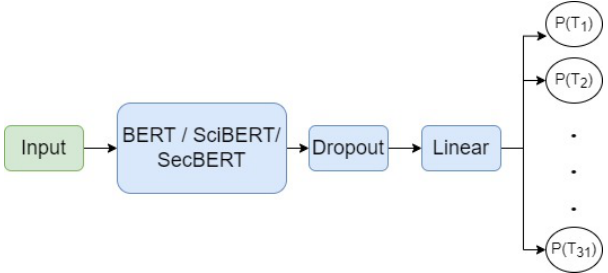
Figure 6. The design of the multi-labeling BERT-based